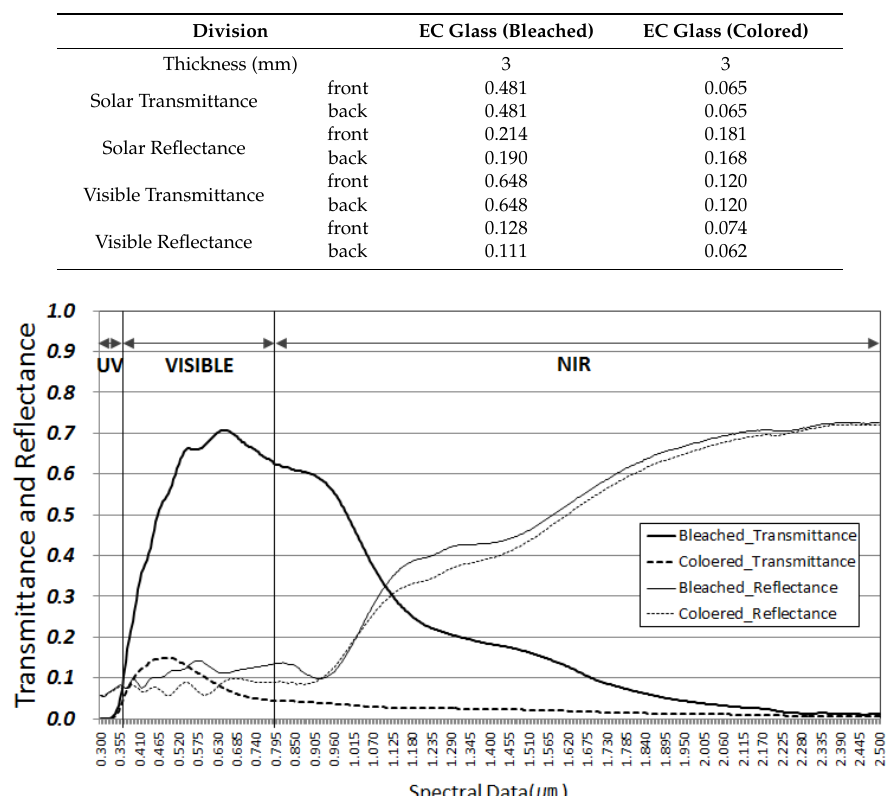
Figure 4. The average spectral data of electrochromic (EC) glass.